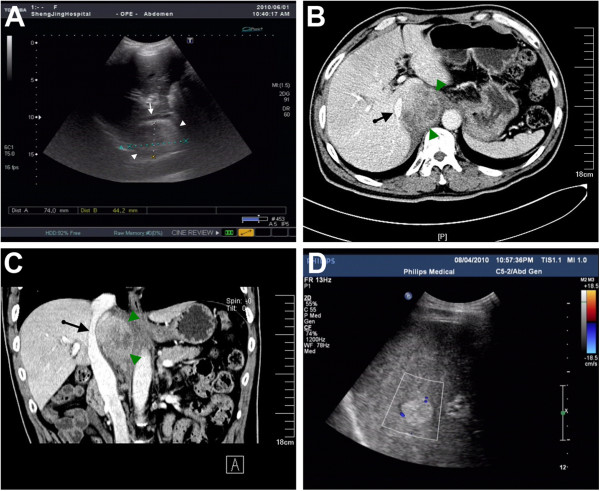
Diagnostic imaging of the retroperitoneal paraganglioma. (A) Abdominal ultrasonography showed a retrocaval mass (indicated by arrowheads) present in the right parasagittal sonographic section. The mass compressed the IVC (indicated by an white arrow) in an anterior direction. (B) Axial contrast-enhanced CT scan showed a non-homogeneously enhanced retrocaval mass (indicated by arrowheads) with necrotic cysts. (C) Coronal contrast-enhanced CT scan showed anterior displacement and extrinsic compression of the IVC (indicated by an black arrow) by the retrocaval mass (indicated by arrowheads). (D) Postoperative abdominal US scan showed multifocal hepatic metastatic lesions (shown in blue).